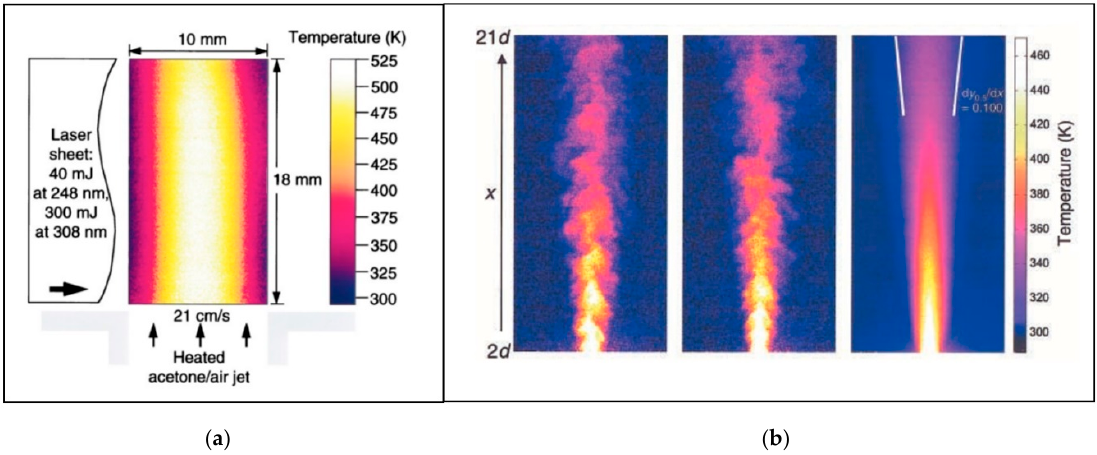
Figure 40. ( a ) PLIF Thermometry measurements from Thurber et al. [187] of a laminar jet heated at 515 K. Reprinted by permission from Ref. [187], Optics Letters, Copyright © 2022 Optical Society of America; ( b ) PLIF Thermometry measurements from Thurber and Hanson [185] of a turbulent jet heated at 465 K. Left and center are instantaneous images. Right is a 100-frame averaged image. Reprinted by permission from Ref. [185], Experiments in Fluids, Copyright © 2022 Springer-Verlag.